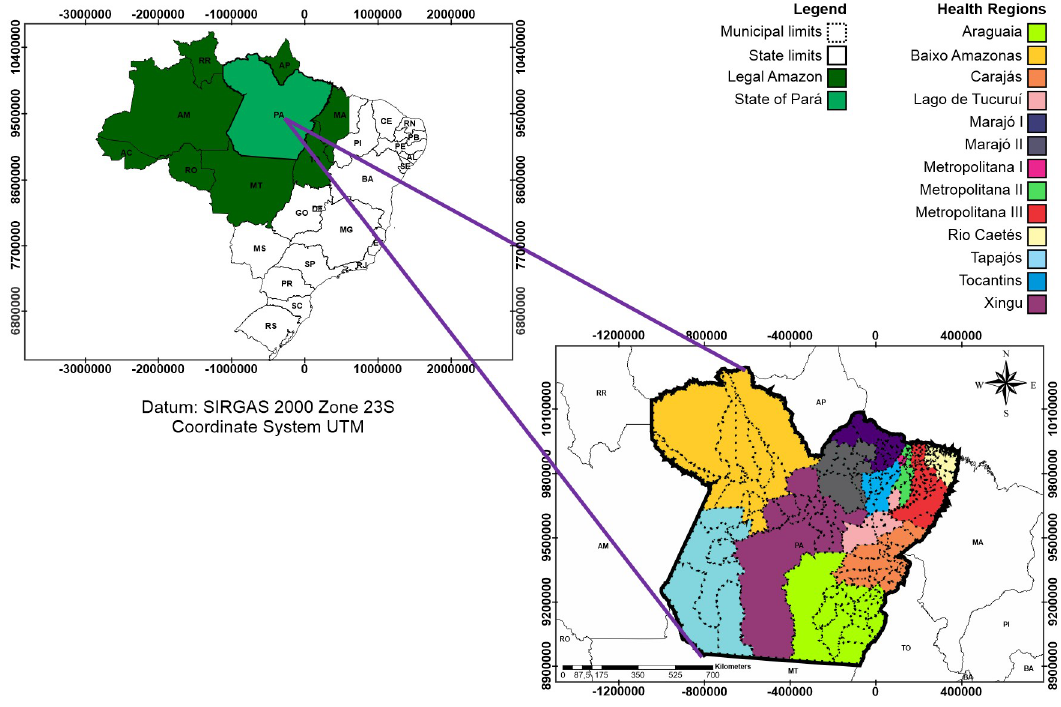
Fig 1. Location map of the Para´ State,